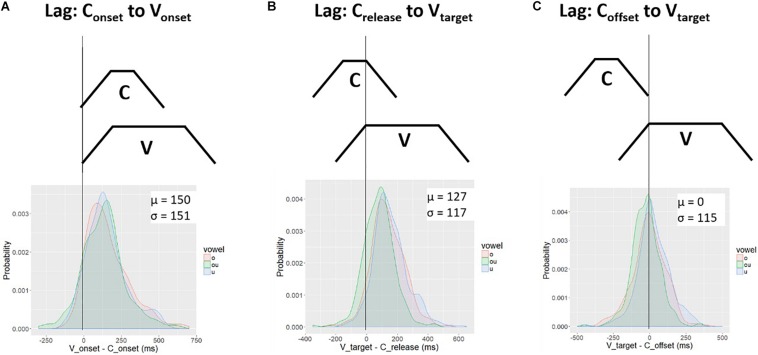
Temporal lag between three sets of C-V landmarks: (A) Conset to Vonset; (B) Crelease to Vtarget; (C) Coffset to Vtarget. The top row shows a schema for the lag measurement. The schema represents the C-V timing pattern under which the lag measure is zero (perfect alignment). The bottom row shows the distribution of lag values. Lag measures were computed by subtracting the vowel landmark from the consonant landmark. The average lag between the Coffset and Vtarget
(C) is zero; in contrast, the average lag for the schemas in (A) and (B) is positive.